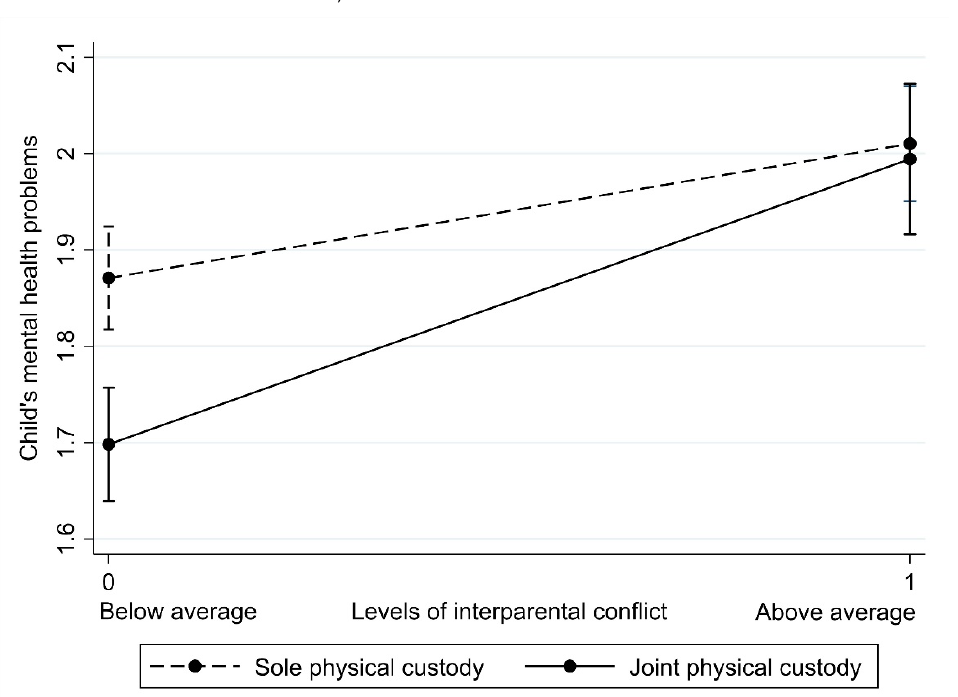
Figure 1 : Interaction between post-separation interparental conflict and the physical custody arrangements in predicting children’s mental health problems (95% confidence